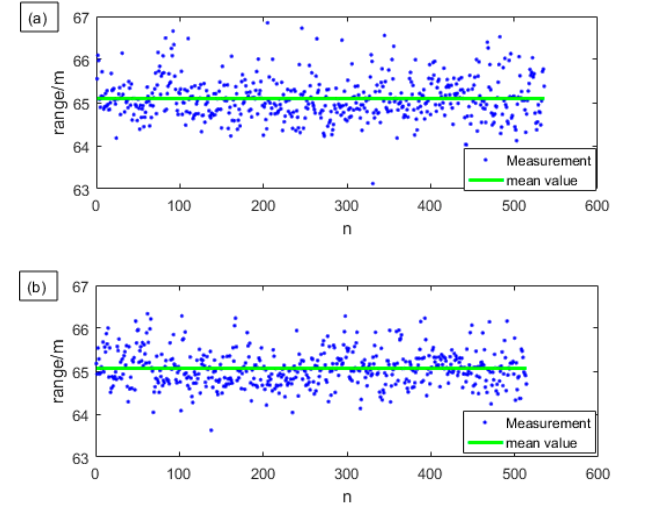
Figure 5. The compressed results of Figure 3 are listed as: (a) I is strong while Q is weak; (b) I is weak while Q is strong; (c) I and Q are almost equal.